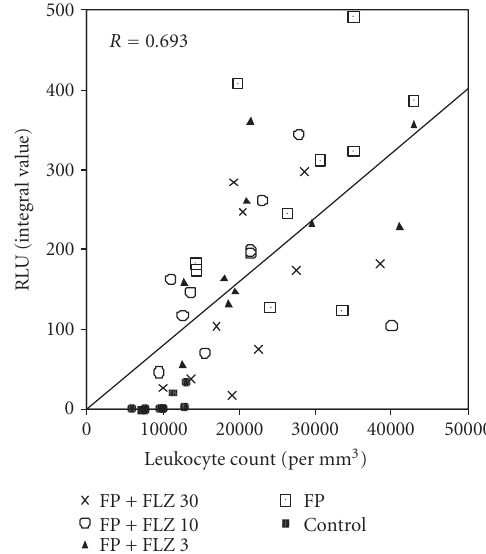
Figure 3. Correlation between chemiluminescence signal and leukocyte count in the peritoneal fluid